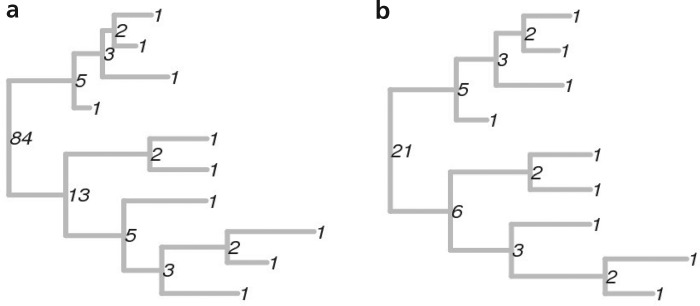
Illustration of the labels of the nodes of binary trees. Tips have the Label \documentclass[12pt]{minimal}
\usepackage{amsmath}
\usepackage{wasysym}
\usepackage{amsfonts}
\usepackage{amssymb}
\usepackage{amsbsy}
\usepackage{upgreek}
\usepackage{mathrsfs}
\setlength{\oddsidemargin}{-69pt}
\begin{document}
}{}$1$\end{document}. Labels of internal nodes are shown in black. The only difference between the trees in (a) and (b) is that in (b), the bottom-most tip from (a) has been removed. As a consequence, most of the labels are the same.